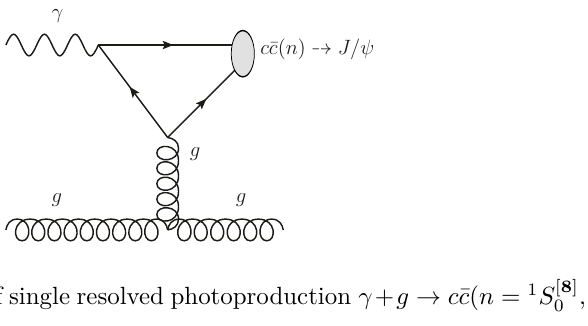
, 3 P [ 8 ] )+ 0 J =0 , 1 , 2